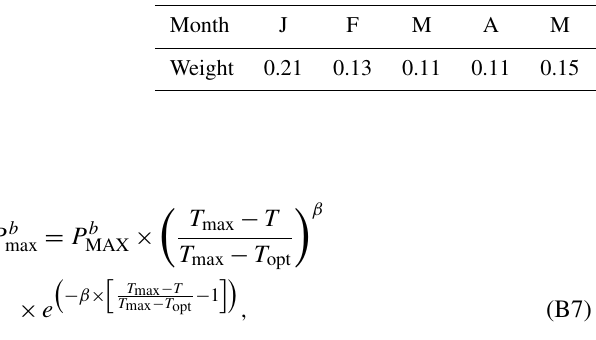
Table B2. Observed mean individual weight of P. ulvae